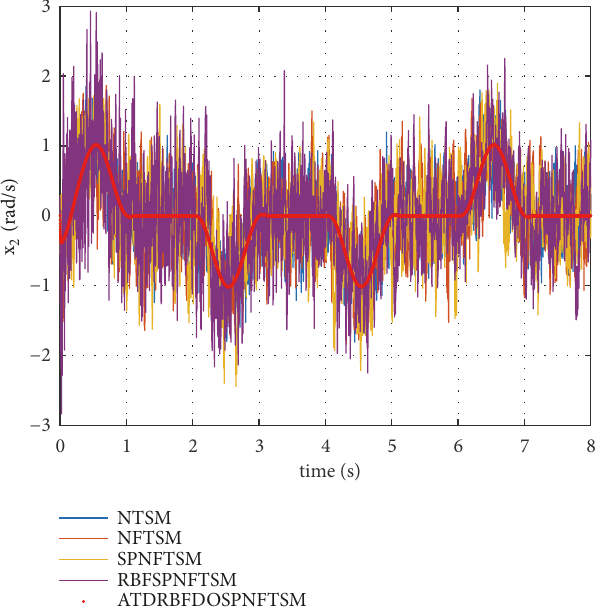
Figure 12: Swing speed response curve (adding